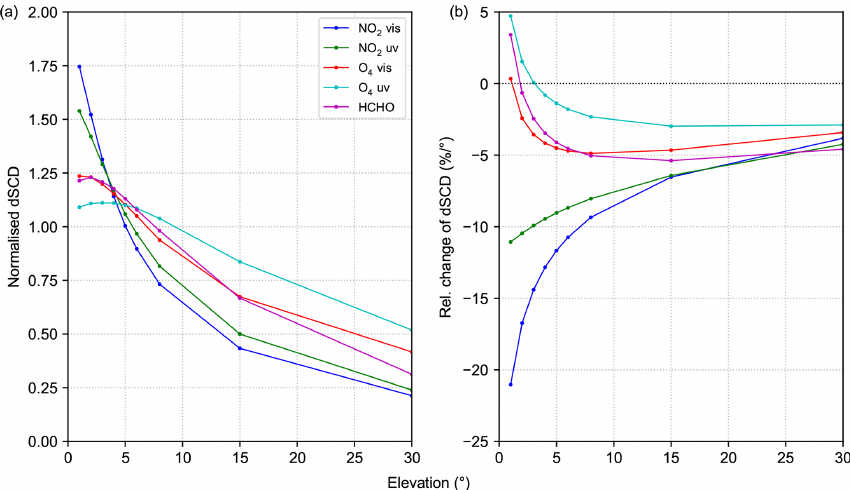
Figure 1. (a) Mean dependence of the trace-gas dSCDs on the elevation angle for the whole campaign. Each curve was normalised to the mean dSCD value of the elevation sequence. (b) Relative change of the measured dSCDs per degree pointing error at different elevation